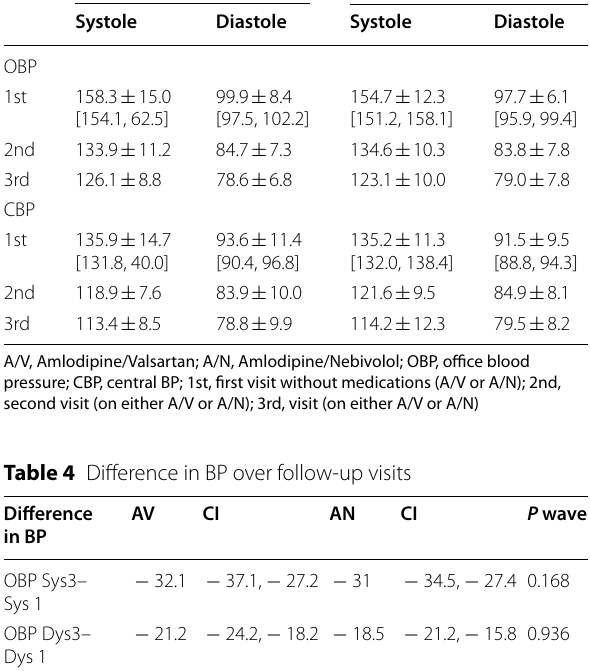
Table 3 Central and peripheral blood pressure at each visit